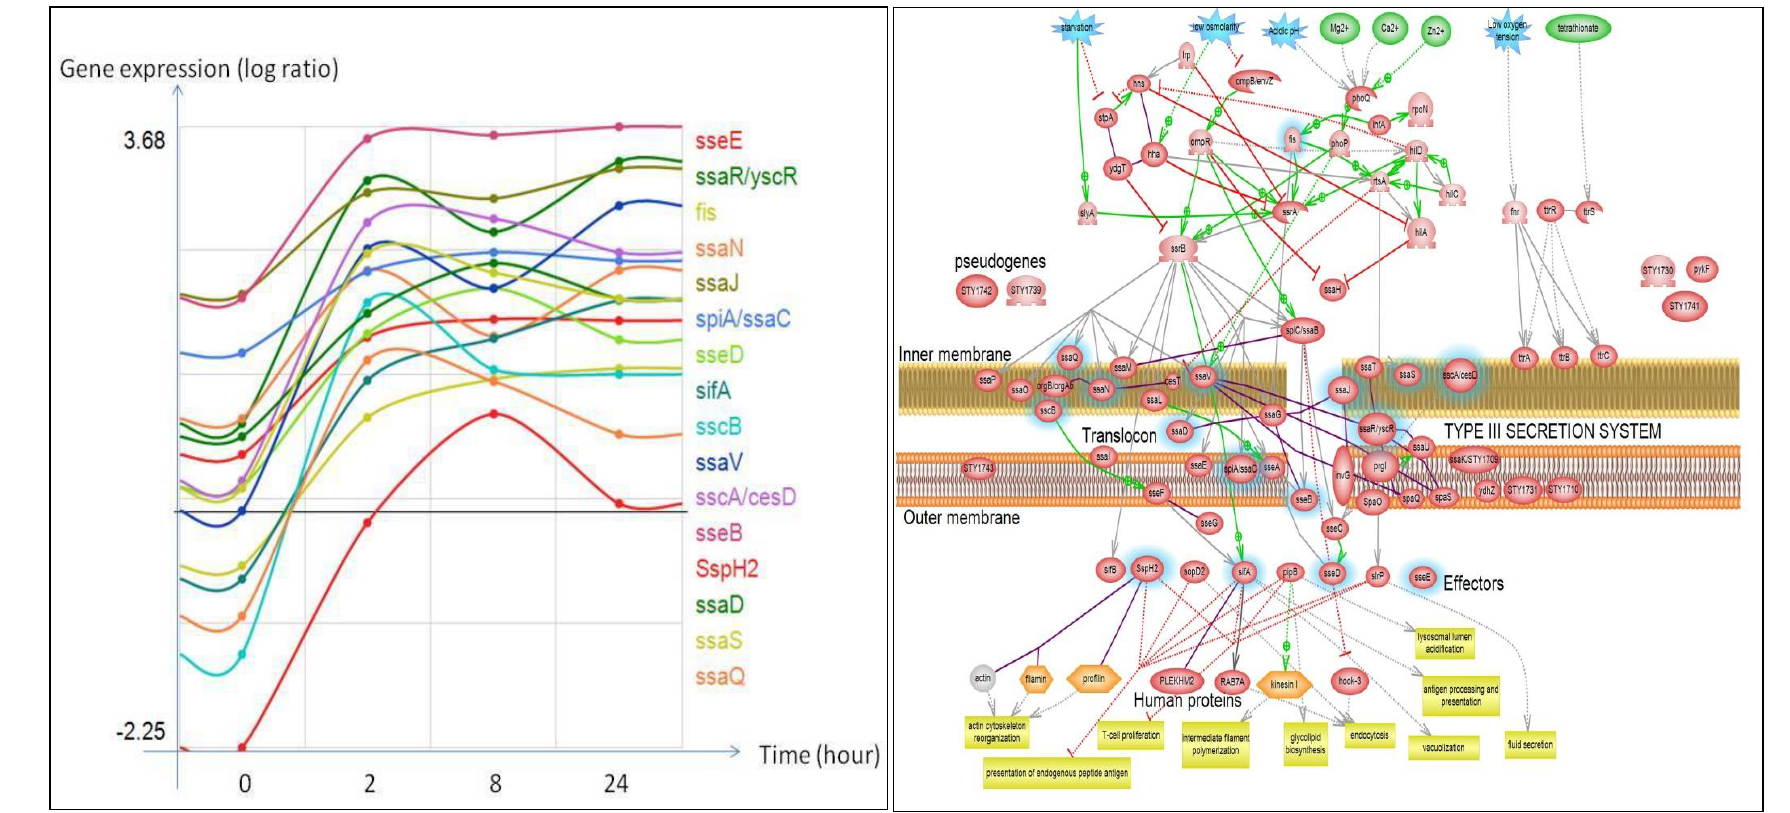
Figure 12b: Cluster 2B. This cluster of genes showed positive correlation during the systemic infection (left). The expression profile corresponds to the proteins highlighted in blue. It can be seen that the main regulator is ssrB and most of the translocon, type III secretion system and effector genes have the similar profile (right). The only transcription factor in cluster 2B is Fis protein. However, fis does directly regulate genes in this cluster but does it through expression of ssrAB operon according to our SPI-2 pathway. The only difference between profiles of cluster 2A and 2B containing ssrAB is expression at 8hrs of infection. Fis is required for activation of ssrA expression in murine macrophages through DNA relaxation [56]. It appears that genes in cluster 2A are more under fis controlled than ssrAB control perhaps because their expression is more sensitive to DNA relaxation than the expression of genes in cluster 2B which appear under stringent ssrAB